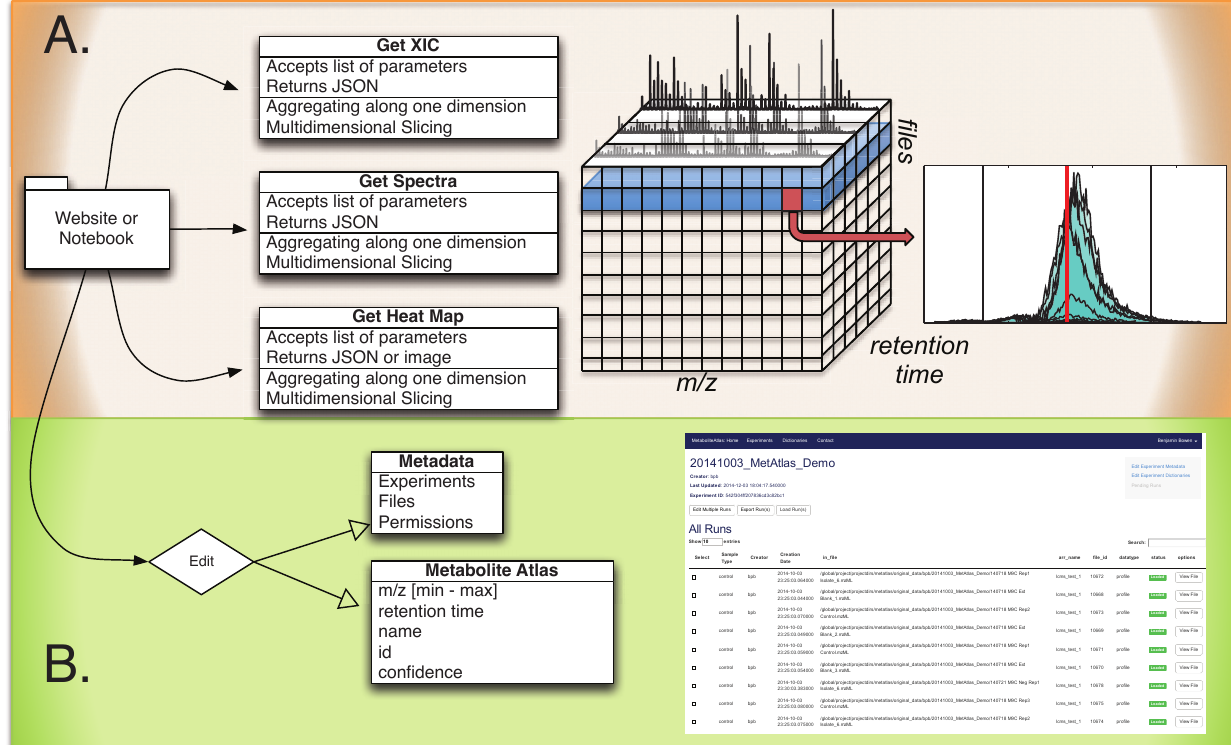
Figure 1. Overview of Metabolite Atlas implementation scheme. ( A ) raw data extraction